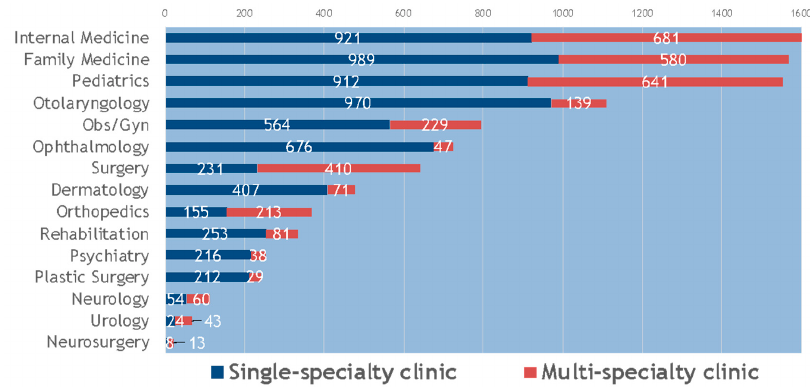
Figure 1. Numbers of single-specialty and multi-specialty clinics, stratified by specialty.